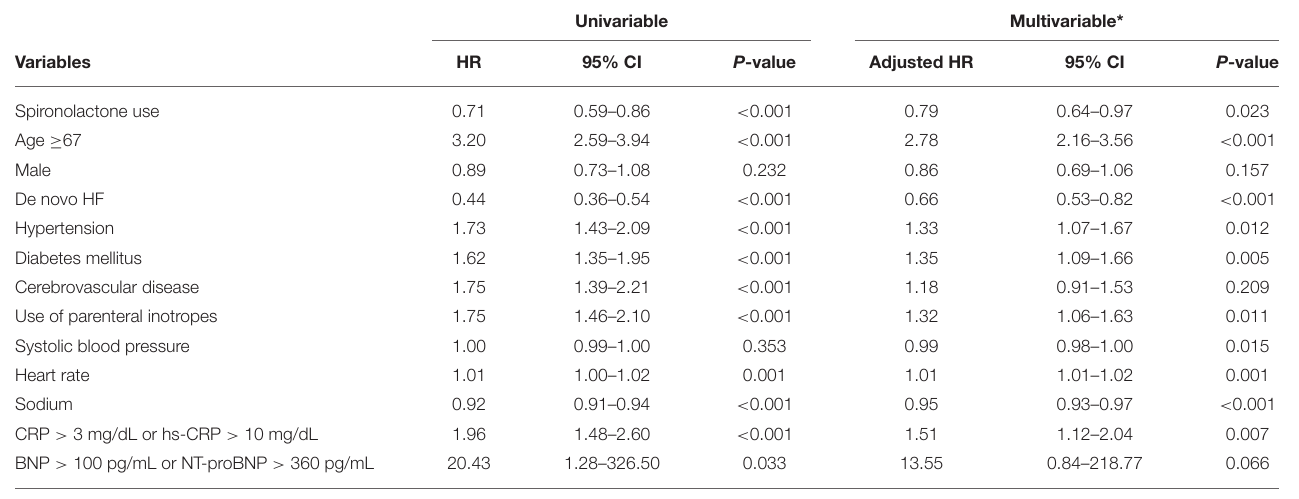
In patients with LVEF ≤ 26% Univariable Multivariable*